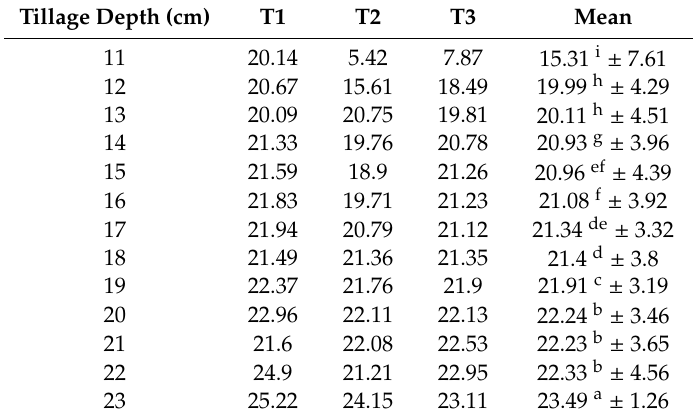
Table 10. Descriptive statistics of rear axle power (kW) according to tillage